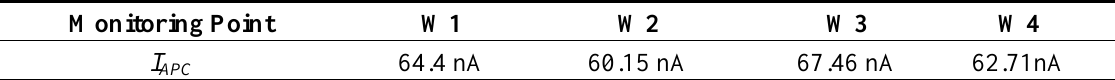
0.0 Table 4. Anodic polarization current of monitoring points after drying for one